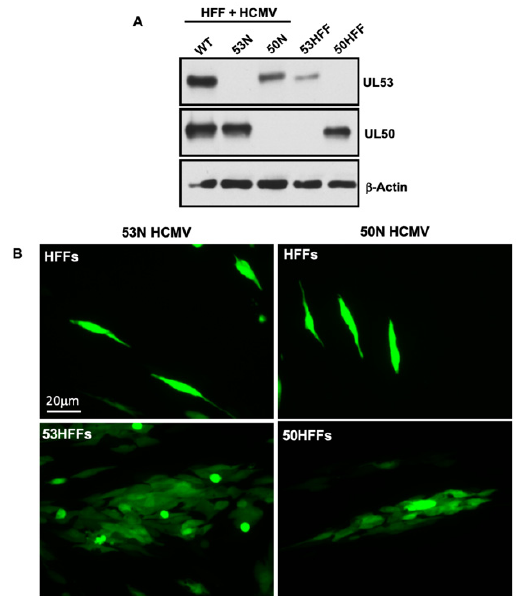
Figure 4. ( A ) HFFs were transduced with lentiviruses expressing UL53 or UL50 creating 53HFFs or 50HFFs, respectively. Expression of UL50 and UL53 in whole cell lysates of WT-infected cells (leftmost lane) was compared with that in uninfected 53HFF and 50HFF (rightmost two lanes), and with HFFs infected with 53N or 50N (second and third lanes from left, respectively) by Western blot, with β -actin as a loading control. Infected cells were harvested at 72 hpi. Cells and viruses used are indicated at the top of the image. Antibodies used are indicated to the right of the image. ( B ) Noncomplementing HFFs (top rows) and 53HFFs or 50HFFs (bottom rows) were electroporated with 53N or 50N GFP BAC DNA and imaged with widefield fluorescence microscopy to assess virus spread at 7